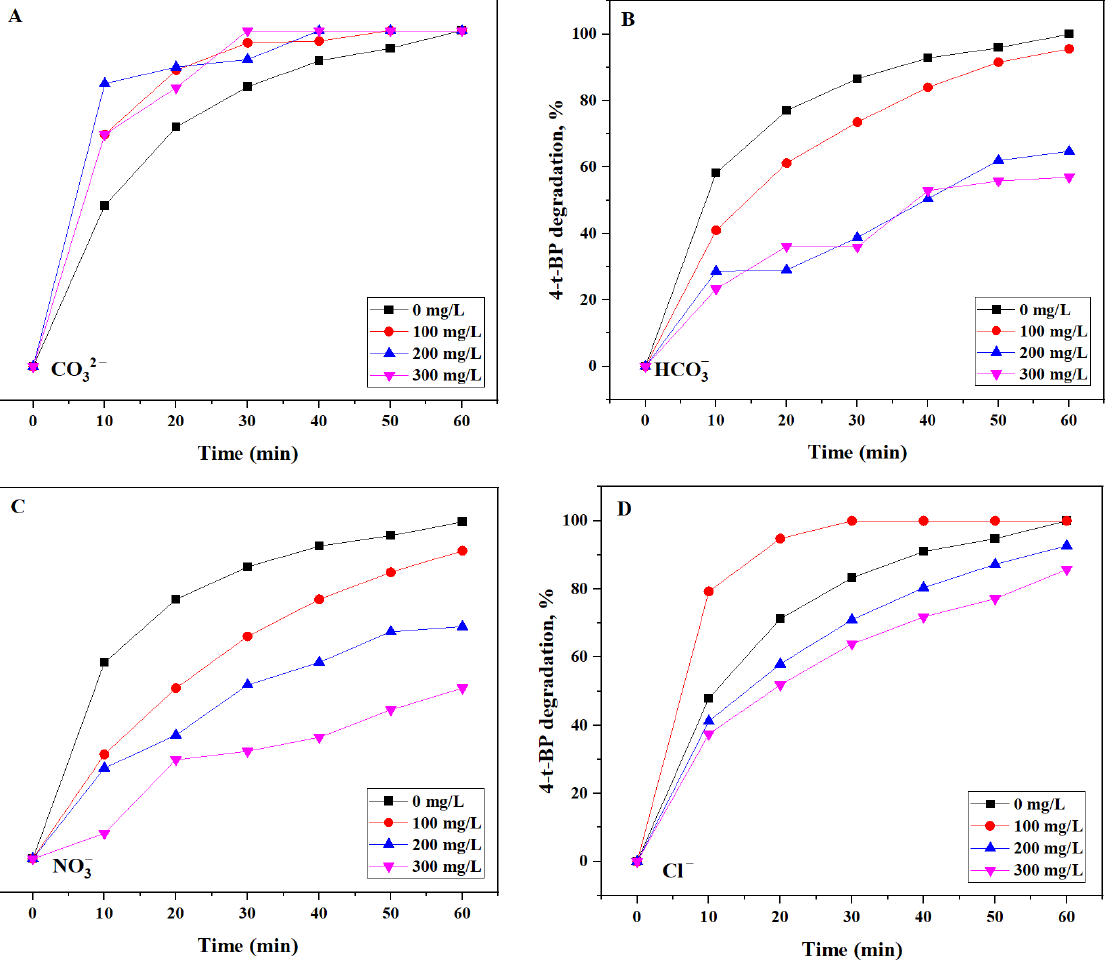
Figure 8. The effect of ( A ) CO 32− , ( B ) HCO 3− , ( C ) NO 3− , and ( D ) Cl − on the degradation of 4-t-BP. Experimental conditions: [4-t-BP] 0 = 5 ppm, catalyst dosage = 200 mg/L. As for HCO 3− and NO 3− (Figure 8B and C), the significant inhibition effect on the per- formance of Ag 2 CO 3 stems from the formation of less reactive radicals [65,66] (Equation